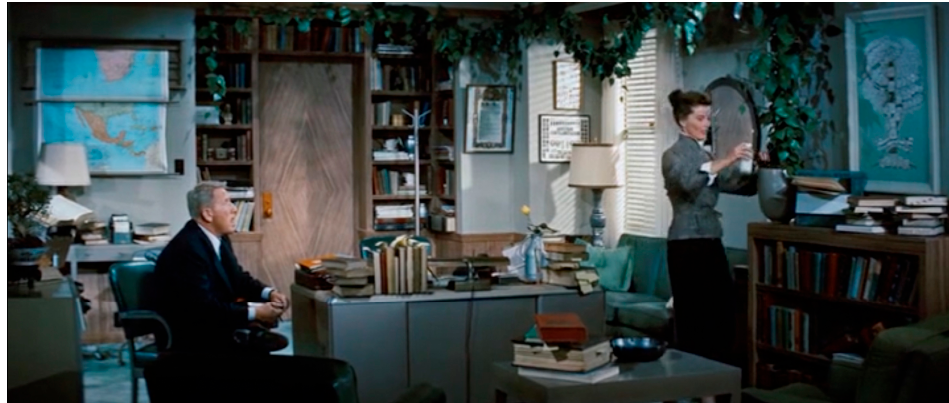
Figure 1. Bunny Watson tends her philodendron.